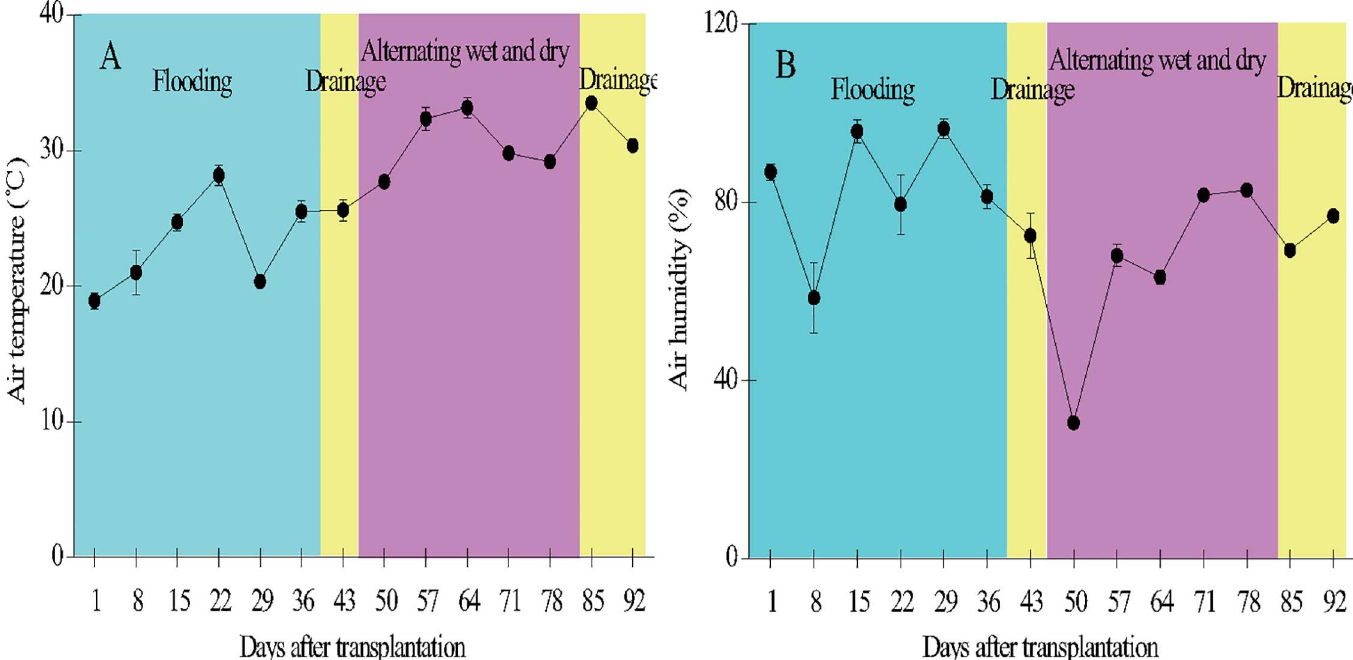
Fig 4. Temporal variation of air temperature (A) and humidity (B) in the paddy field. Error bars indicatethe standard error of the mean of triplicate